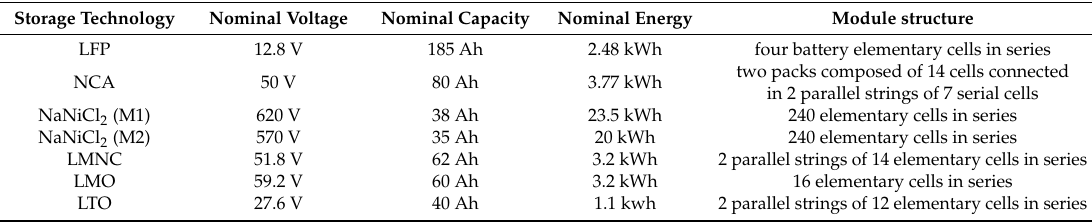
Table 3. Main electrical characteristics of the tested